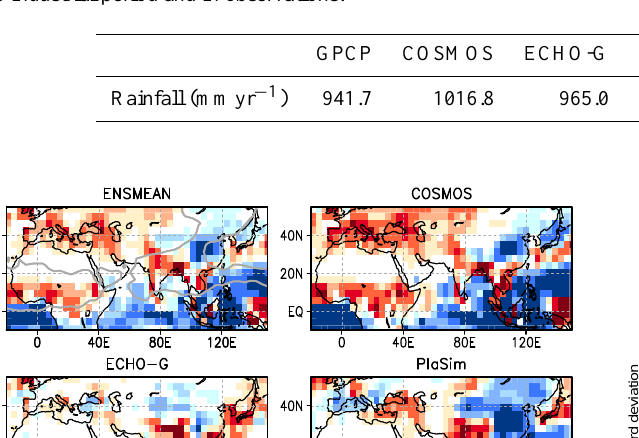
Table 2. Absolute rainfall (mmyear − 1 ) in the ensemble mean Afro-Asian monsoon region (including land and ocean, cf. Fig. 2) during the pre-industrial period and in observations.